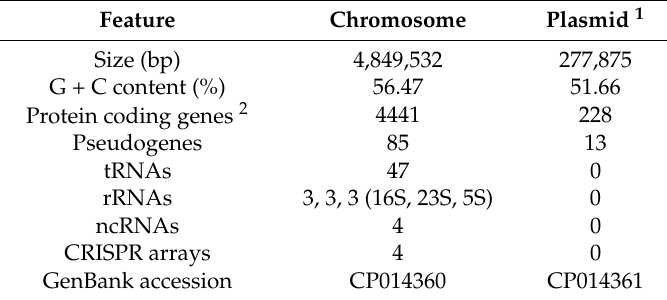
Table 1. The general genome features of Methylomonas sp. DH-1.